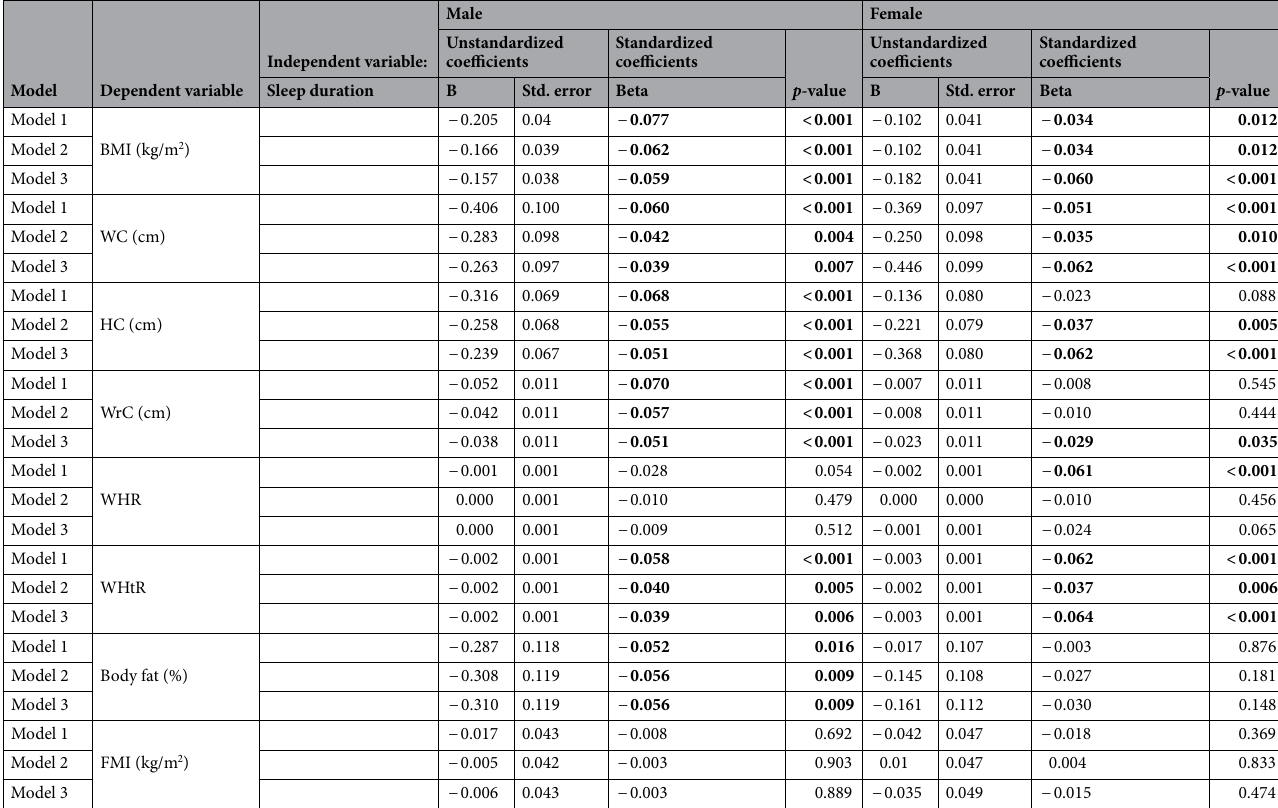
Table 3. The linear regression models of anthropometric data, body fat percentage and fat mass index with 24-h sleep duration as a continuous variable in both gender. Standardized regression coefficients calculated